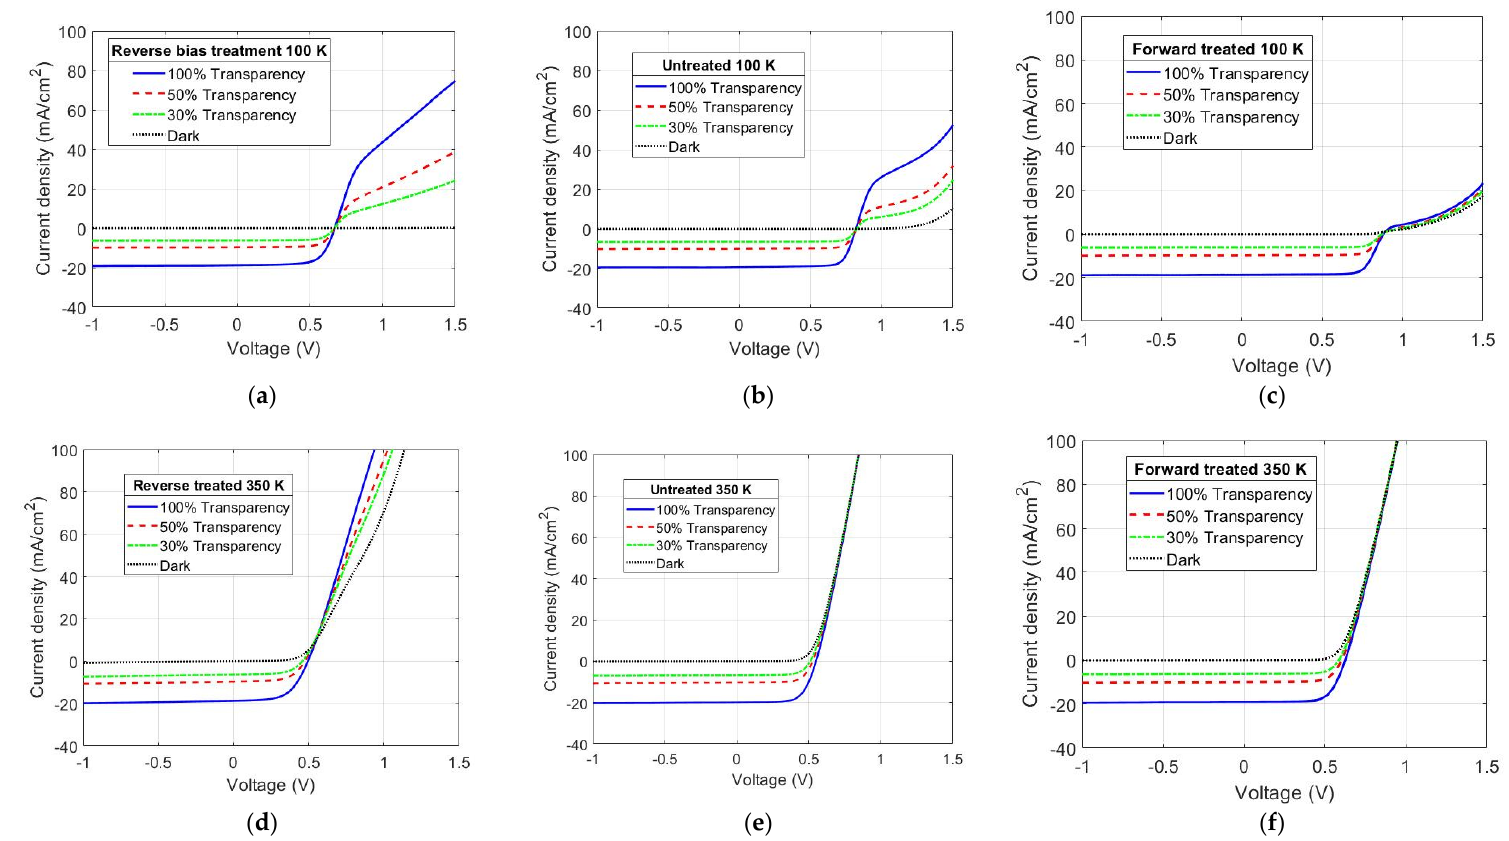
Figure 2. Measured J–V curves with different illumination values. Plots ( a – c ) correspond to the sample treated with a reverse bias, the non-treated sample and the sample treated with a forward bias, respectively, at 100 K. Plots ( d – f ) correspond to the previously indicated samples, respectively, at 350 K. J–V results with different transmission filters are also shown.